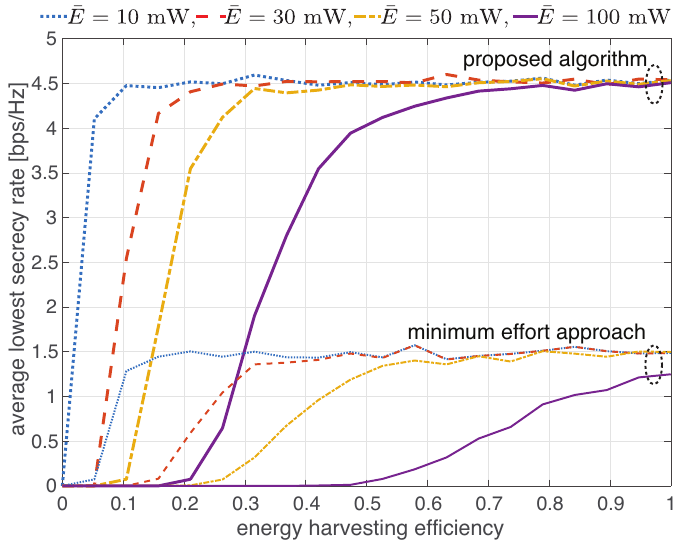
Figure 6. Average of the lowest total secrecy rate as a function of minimum required harvesting energy with varied transmit power.